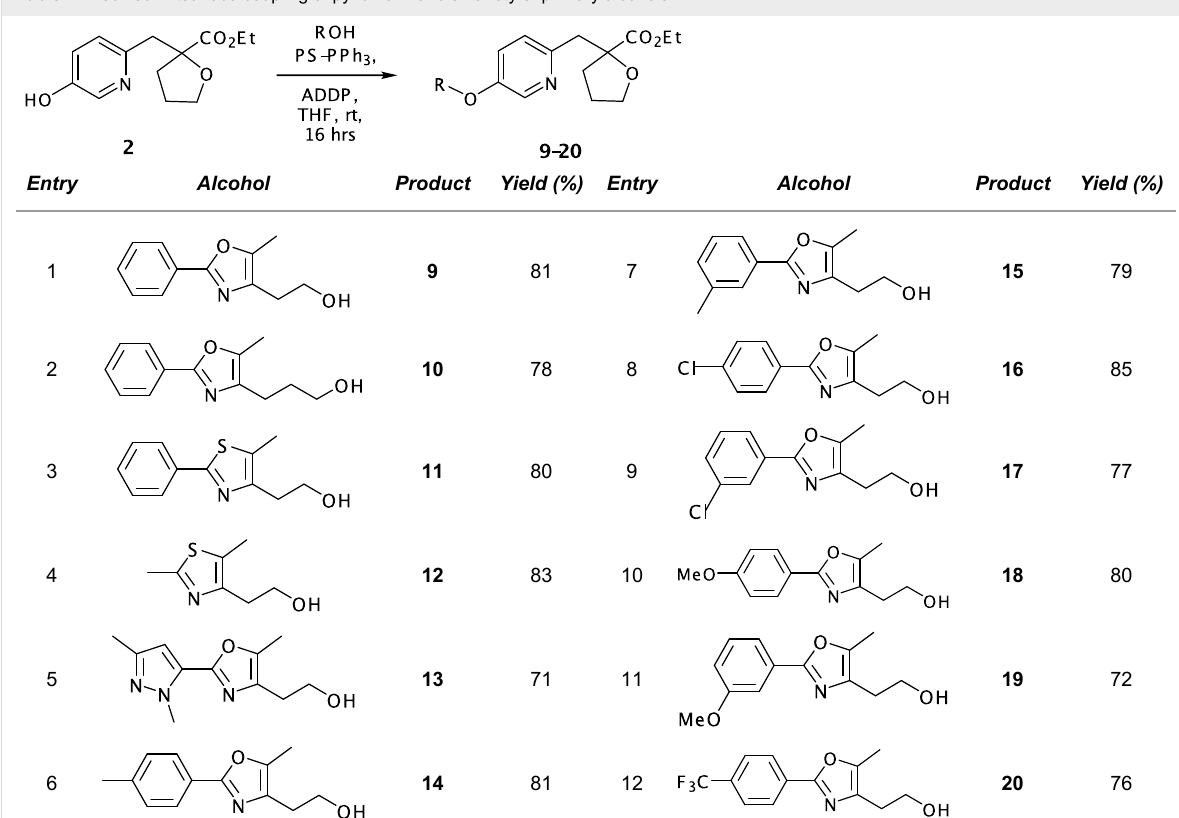
Table 1: Modified Mitsunobu coupling of pyridinol 2 and a variety of primary alcohols a